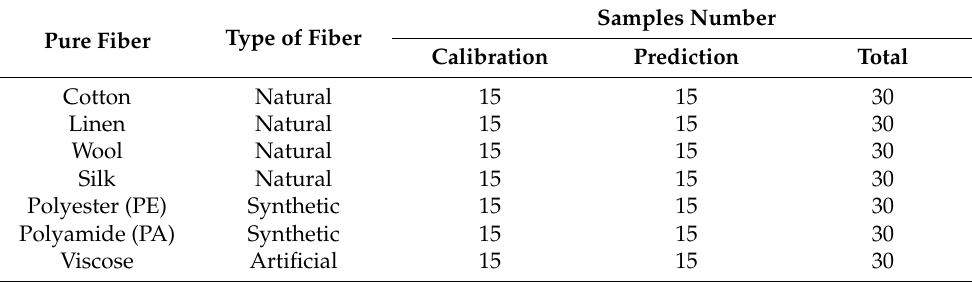
Table 2. Study #1: Pure textile samples.